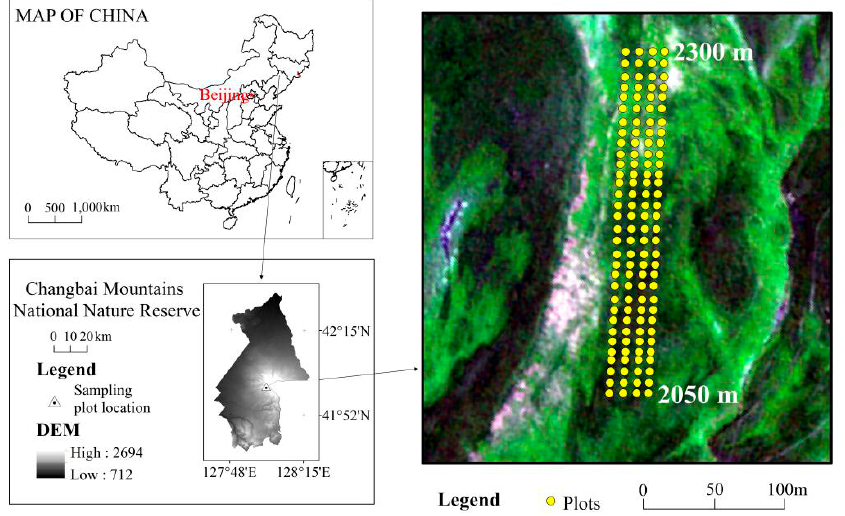
Figure 6. Location of the study area and sampling sites.